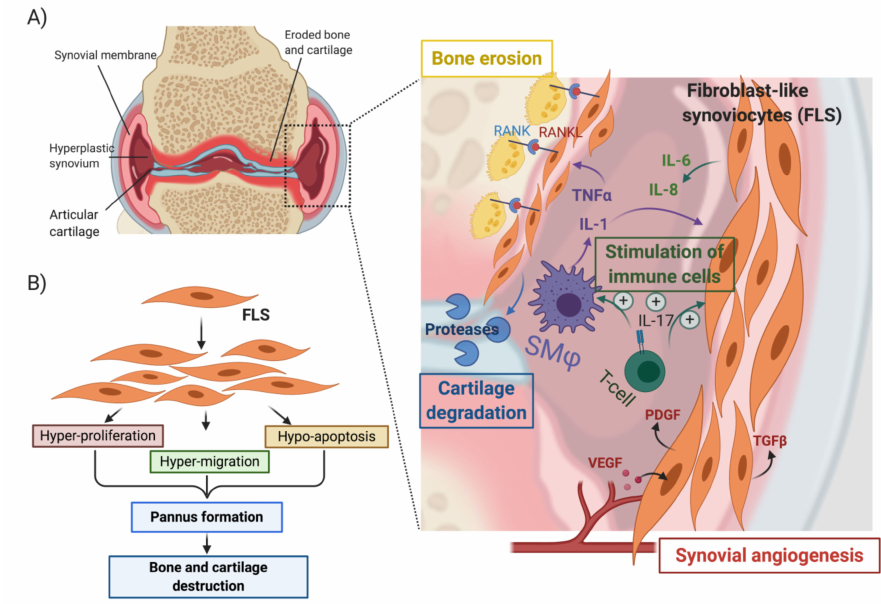
Figure 4. Role of synoviocytes in pannus formation and bone erosion in rheumatoid arthritis ( A ) and ( B ) activation of fibroblast-like synoviocytes by cytokines (TNF- α and IL-1 β ) secreted by synovial macrophages. (SM φ ) leads to the acquisition of a hyper-proliferative, hyper-migratory and hypo- apoptotic phenotype that contributes to the formation of a hyperplastic synovium and ultimately leads to bone and cartilage erosion. Activated synoviocytes in the pannus play a central role in the recruitment and stimulation of immune cells, the vascularization of the pannus through activation of angiogenesis, and the promotion of cartilage and bone erosion. Created with